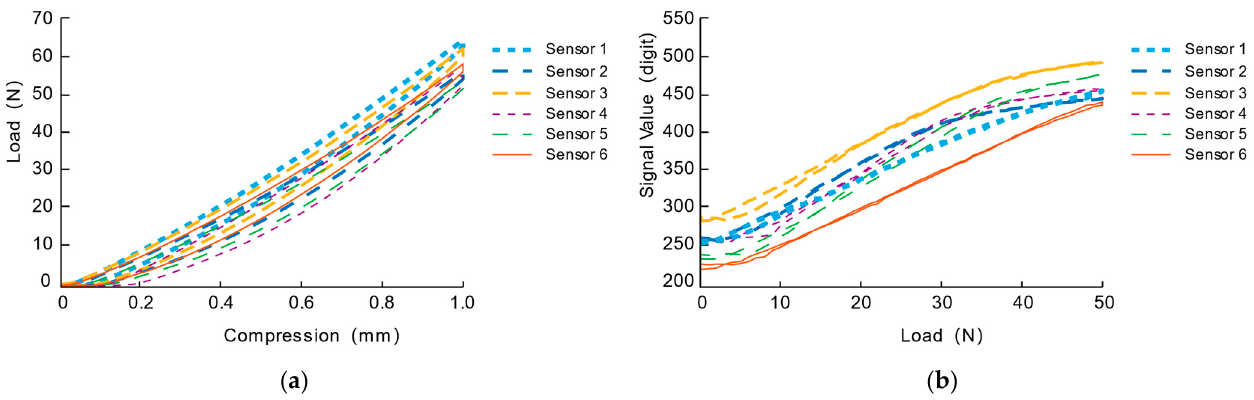
Figure 9. The mechanical and electrical characteristics. ( a ) The mechanical characteristics ( b ) The electrical characteristics. Table 1. Fitting Result of Sensing Unit Electrical Characteristic. Sensor